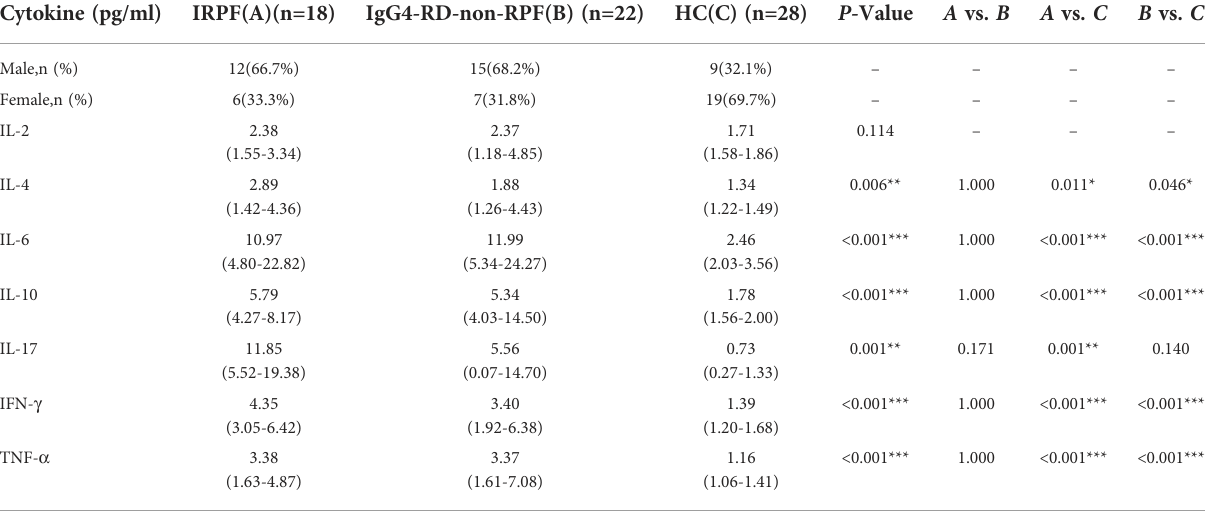
TABLE 3 Serum cytokine levels in IRPF group(A), and IgG4-RD-non-RPF(B) and Healthy control group(C). Cytokine (pg/ml)